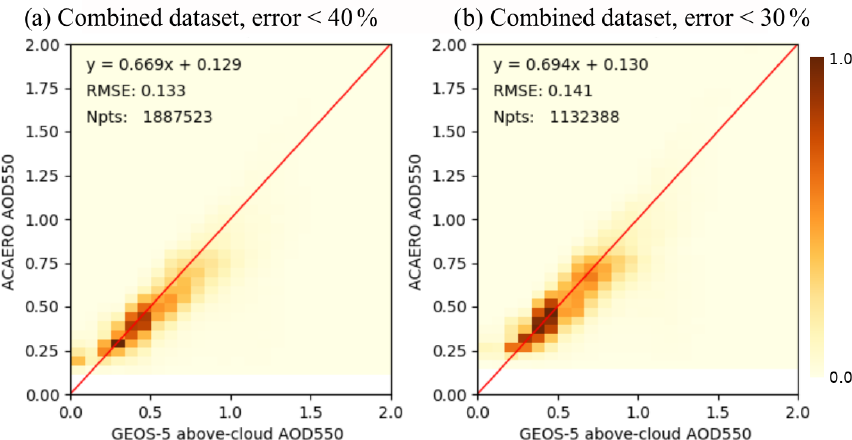
Figure 4. MOD06ACAERO retrieval results from the combined dataset of Fig. 3a compared to source GEOS-5 aerosol optical depth as a normalized density plot. No screening of retrievals had been performed except for pixel-level uncertainty. Panel (a) shows MOD06ACAERO retrievals with uncertainty of less than 40%, and panel (b) shows the same with uncertainty less than 30%.